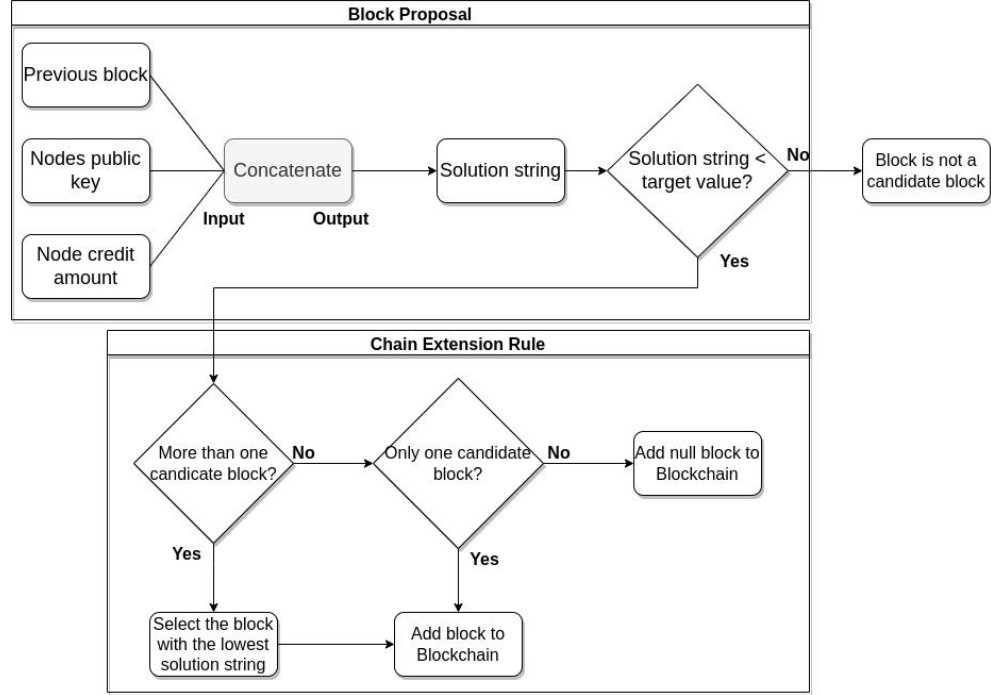
Figure 8. Microchain